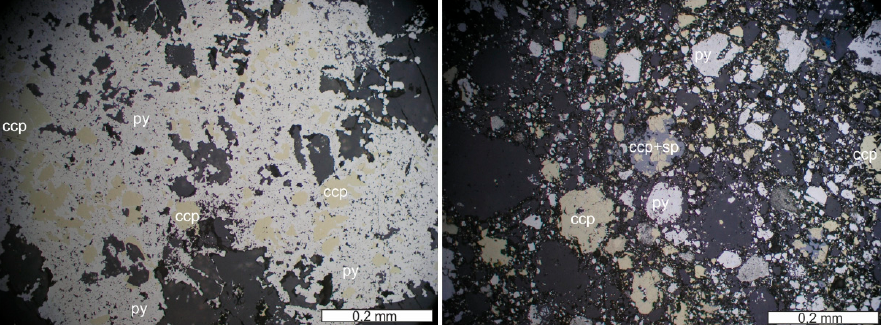
Figure 2. Massive sulfide (py—pyrite; ccp—chalcopyrite) with gangue minerals (quartz and calcite) from Corchia (reflected light microphotograph, 1N; left) and brecciated ore (pyrite, chalcopyrite; sp—sphalerite) with gangue quartz and calcite from Corchia (reflected light microphotograph, 1N; right).